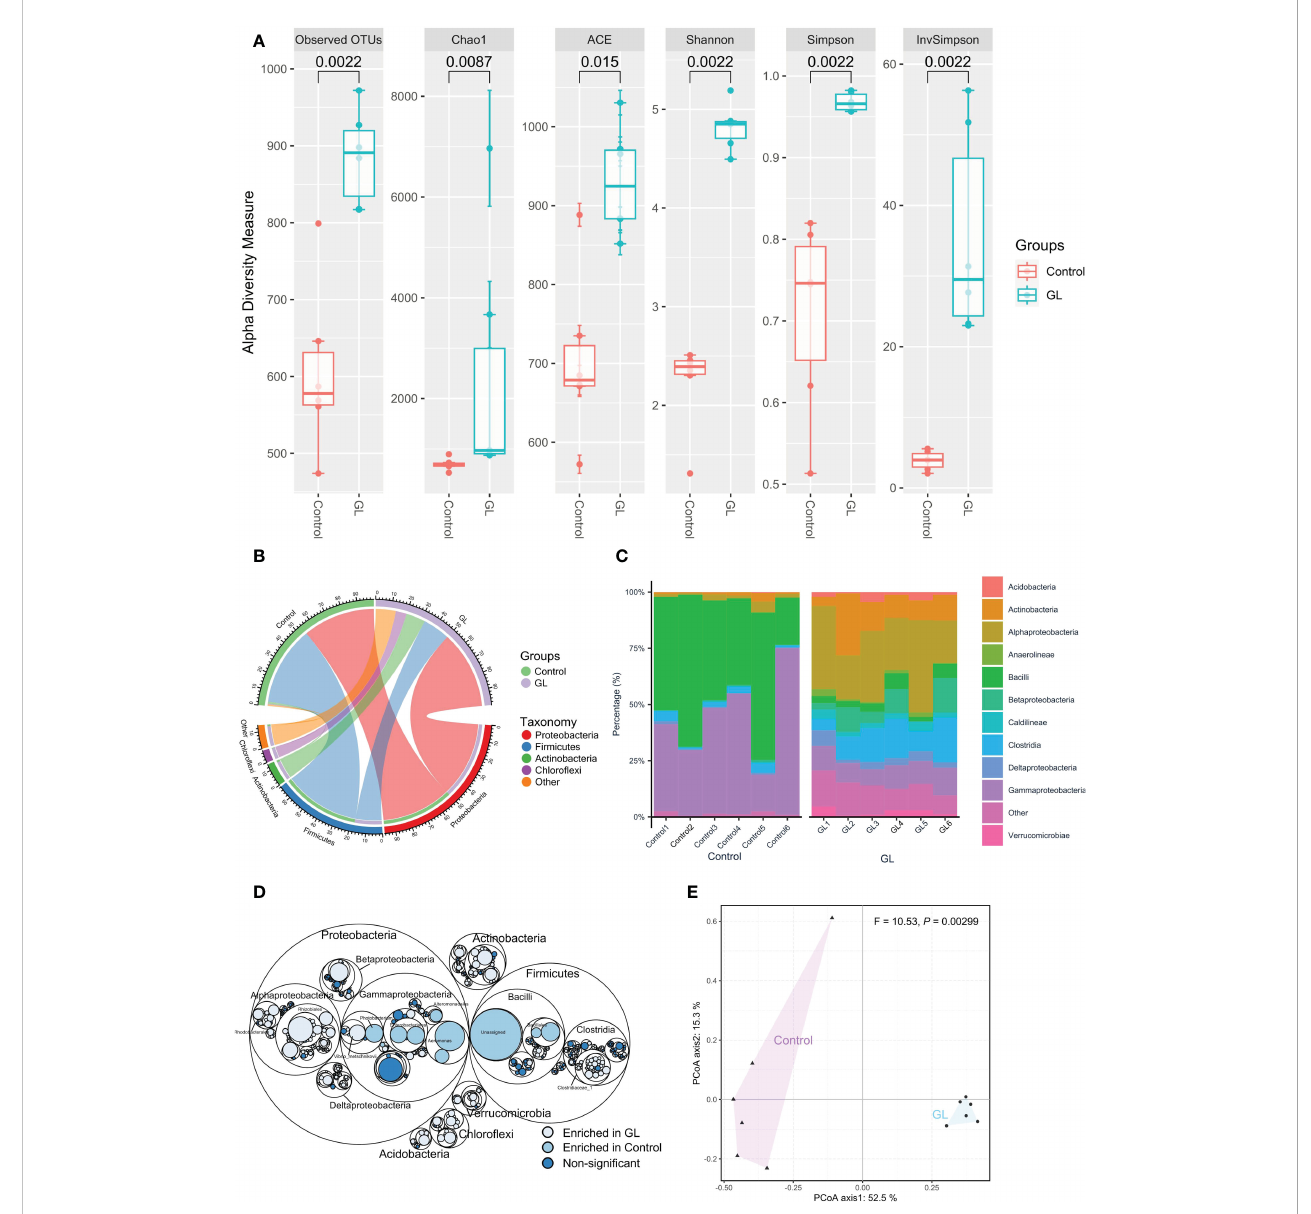
FIGURE 1 The effects of b -1,3-glucan on the composition of intestinal microbial community of Litopenaeus vannamei . (A) The a -diversity of the intestinal microbiota; (B) The relative abundance of species above ≥ a cutoff value of 2%; (C) The close lots of the top 10 classes; (D) Maptree plot descriptions of the taxonomic differences. The giant circles represent species level; the inner circles represent class, order, family, and genus for the panel; (E) PCoA analysis visualizing dissimilarities in the intestinal microbial community through permutational analysis of variance (PERMANOVA) based on the Bray – Curtis